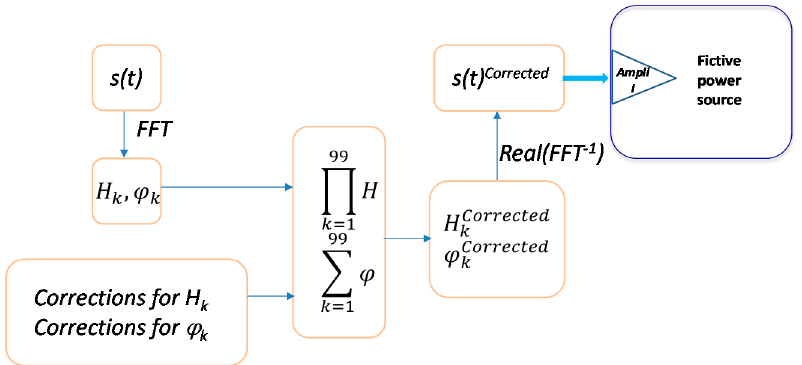
Figure 4. Diagram to apply corrections.